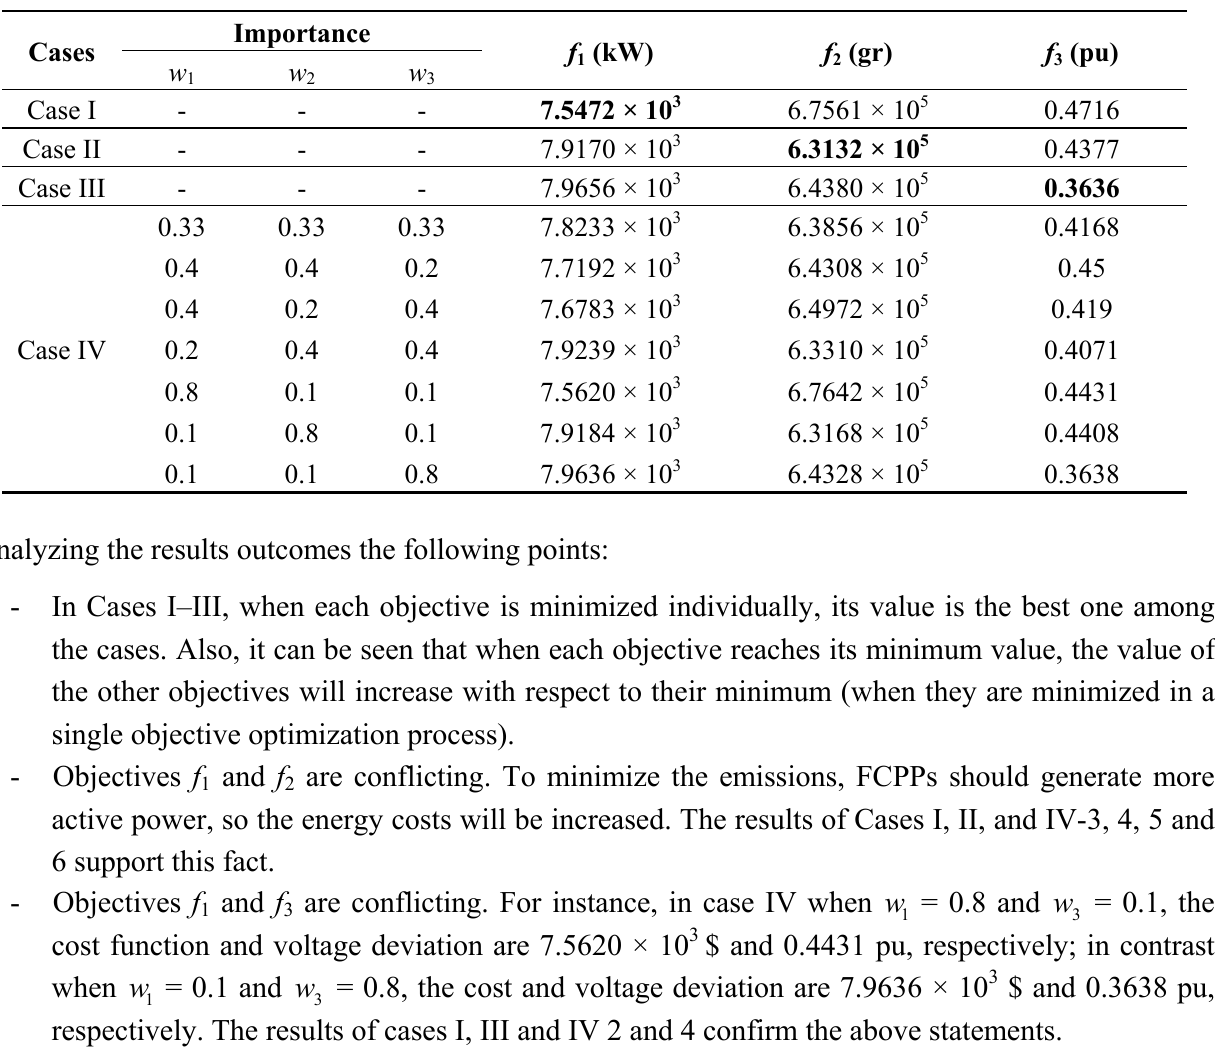
Table 9. Fuzzy decision making on Pareto optimal